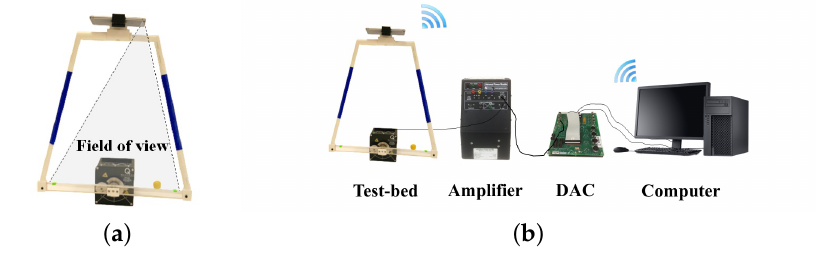
Figure 7. ( a ) Smartphone-mounted ball and beam and ( b ) experimental setup with a PC-based